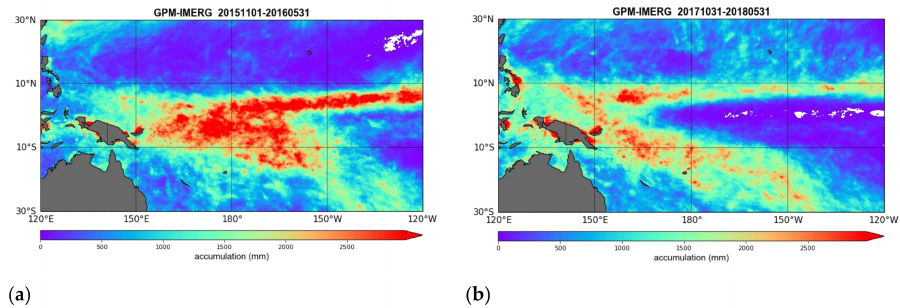
Figure 14. Comparison of GPM IMERG 7-month accumulated precipitation (mm) during November 2015–June 2016 ( a ) and November 2017–June 2018 ( b ). Approximate domains of the RAMA, TAO/TRITON and PIRATA moored arrays are shown. The color scale extends from 0 to 3000